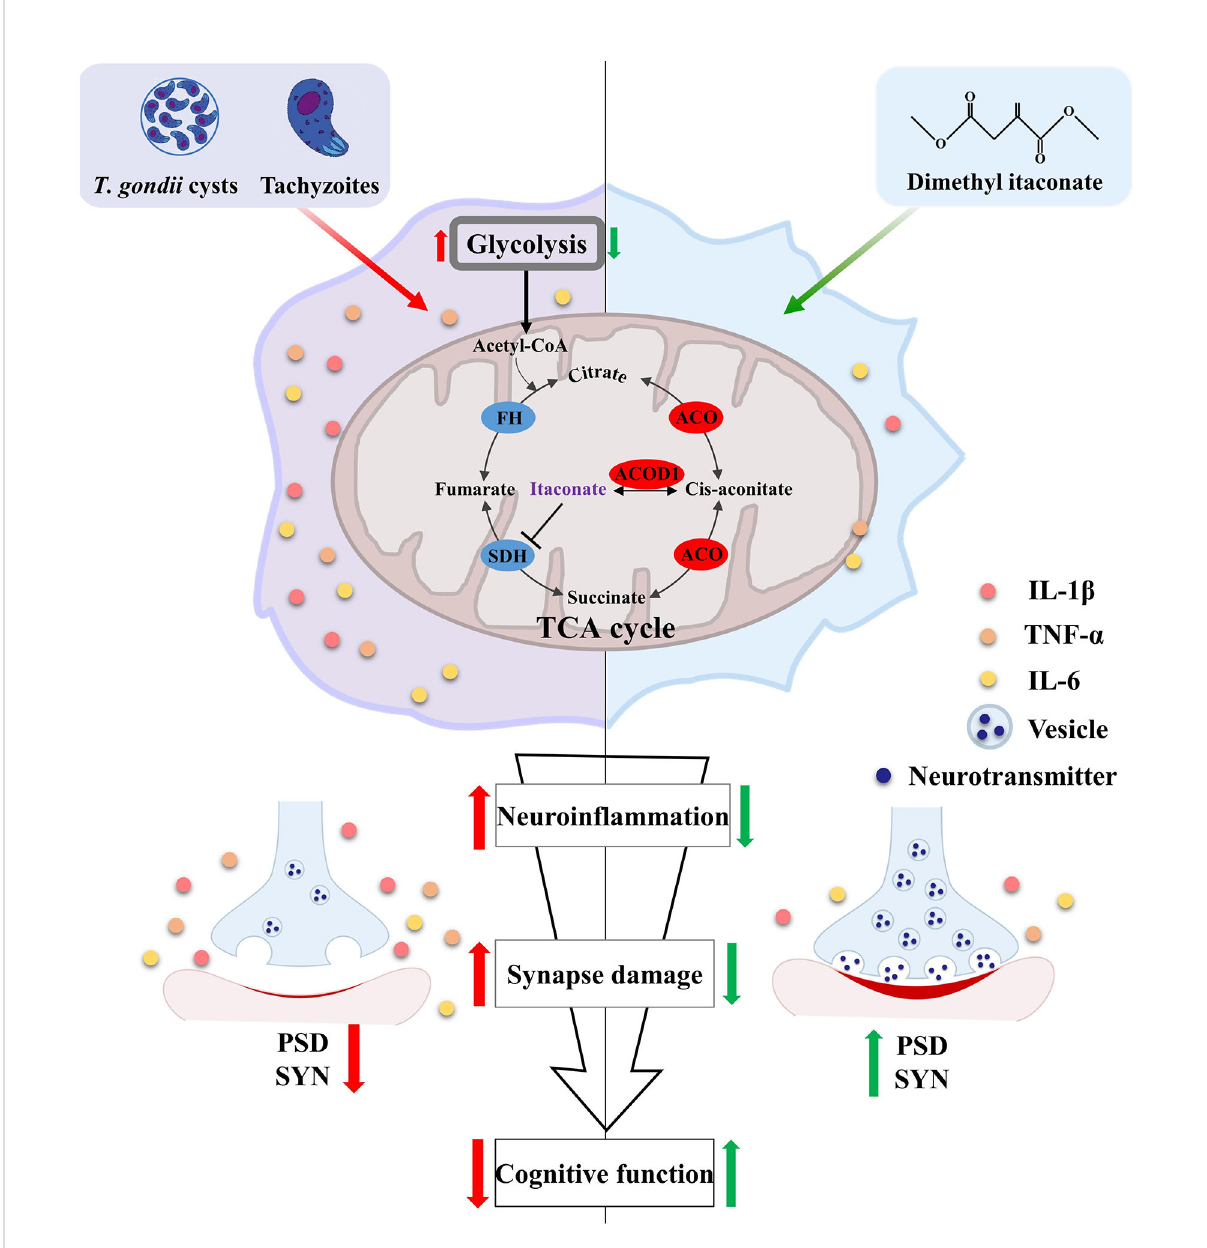
FIGURE 8 Schematic strategy of how dimethyl itaconate improves the cognitive de fi cits induced by T. gondii infection. T. gondii infection induces neuroin fl ammation along with Acod1/itaconate axis disorder in the hippocampus of mice. These activated immune cells ( e. g. microglia) can impair the synaptic plasticity via engul fi ng the synaptic plasticity-related proteins (SYN and PSD95), thereby causing cognitive de fi cits. However, DI supplementation can signi fi cantly attenuate the cognitive de fi cits and neuropathological changes induced by T. gondii infection. Red arrows represent the consequent events following T. gondii infection; Green arrows represent DI ’ s pro-cognitive